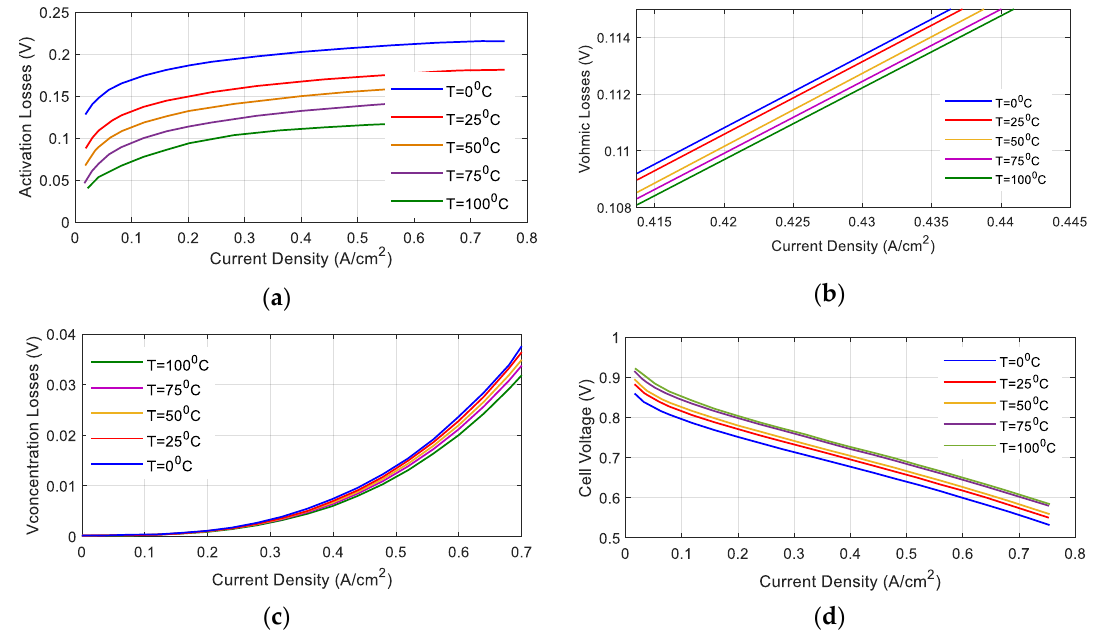
Figure 7. Effect of temperature on ( a ) Activation overvoltage, ( b ) Ohmic overvoltage, ( c ) Concentration losses, ( d ) Cell voltage loss.